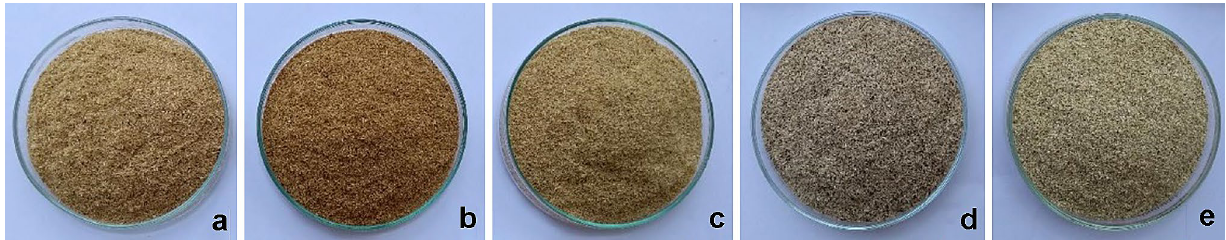
Fig. 2 Alternative materials used in the experiment. Bamboo: Bambusa vulgaris. Var. Vittata ( a ), Dendrocalamus asper ( b ), Phyllostachys aurea ( c ); mate ( Ilex paraguariensis ): branches ( d ) and thin sticks ( e